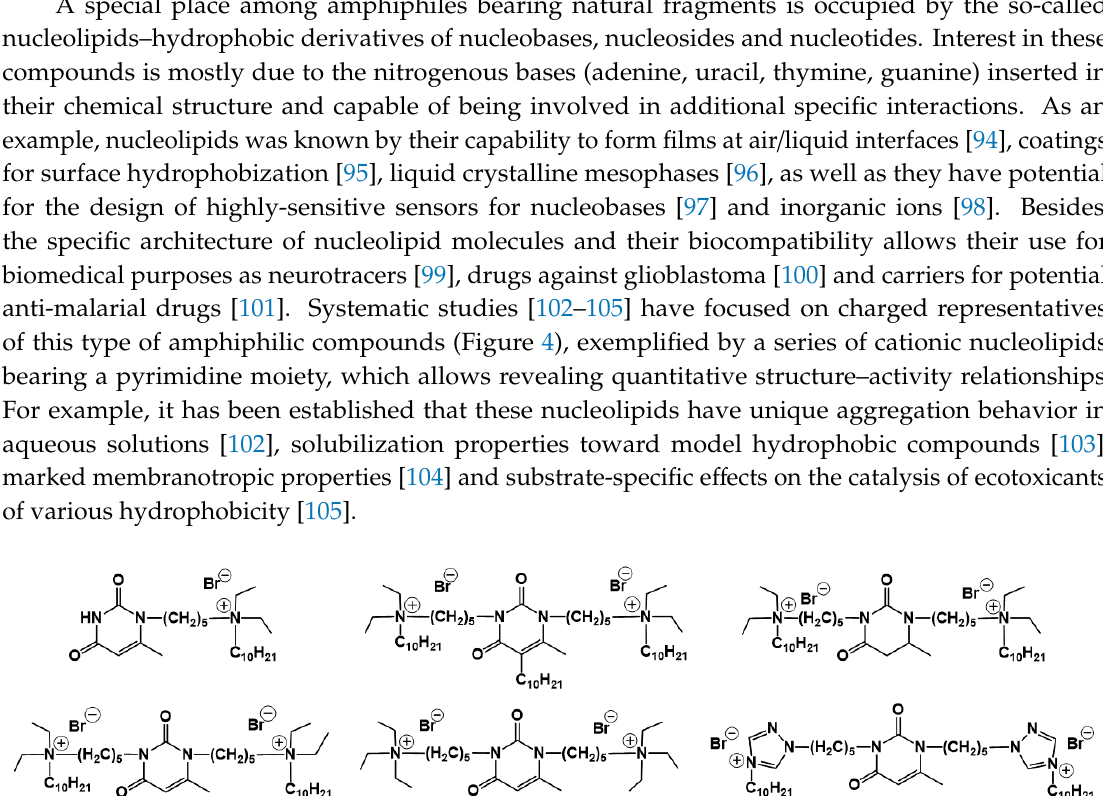
Table 3. CMC values and solubilization power S toward hydrophobic Orange OT for nucleolipids of various structures investigated in our reports.